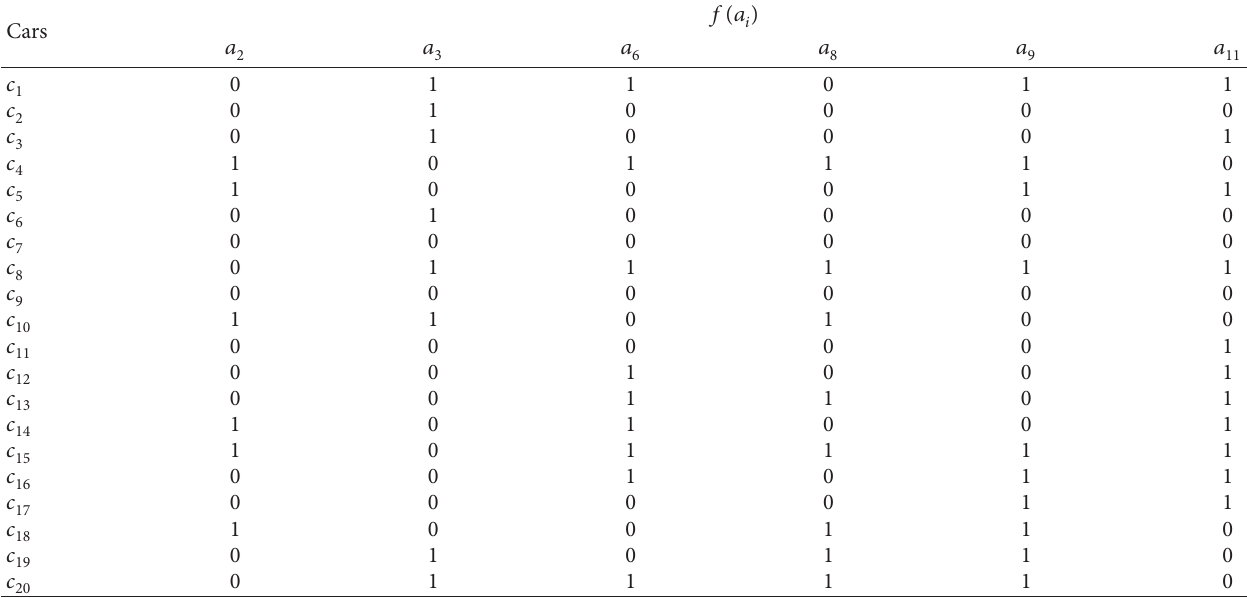
Table 1: The positive components f of bipolar soft sets ( f,g,E ) of each car.